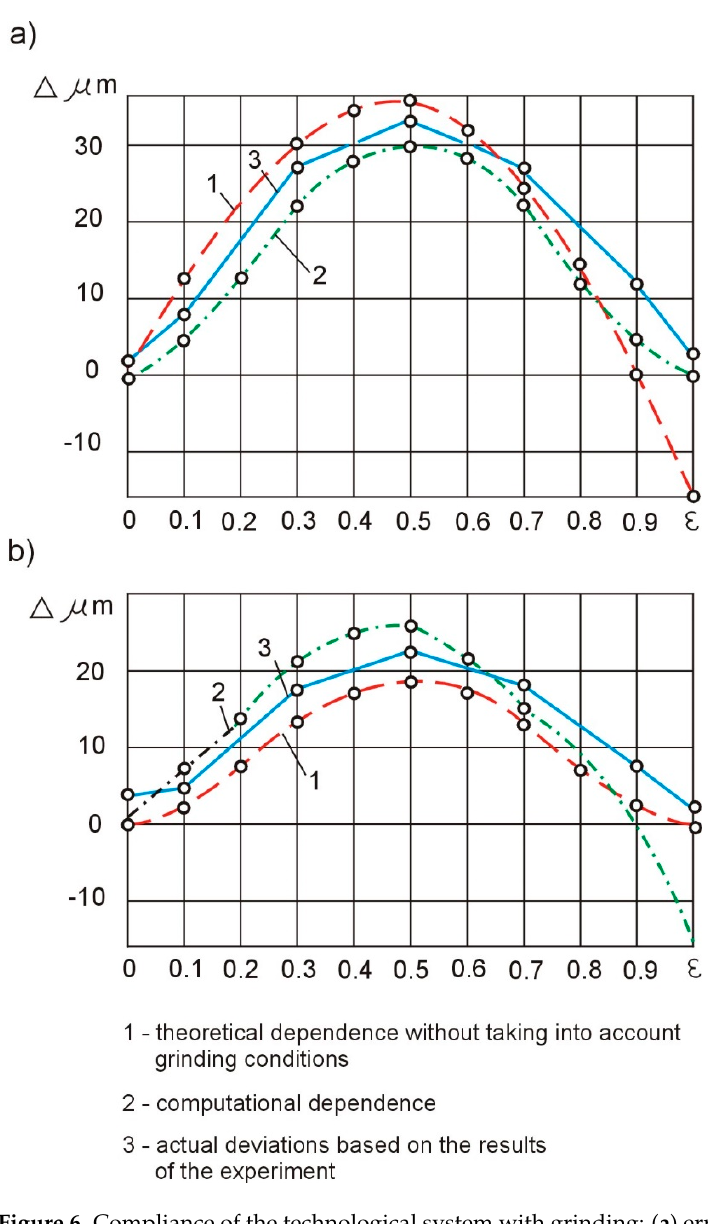
Figure 6. Compliance of the technological system with grinding: ( a ) errors of cylindricity of shafts mounted in rigid centers for diameter d = 8 mm, and ( b ) errors of cylindricity of shafts mounted in rigid centers for diameter d = 14 mm.